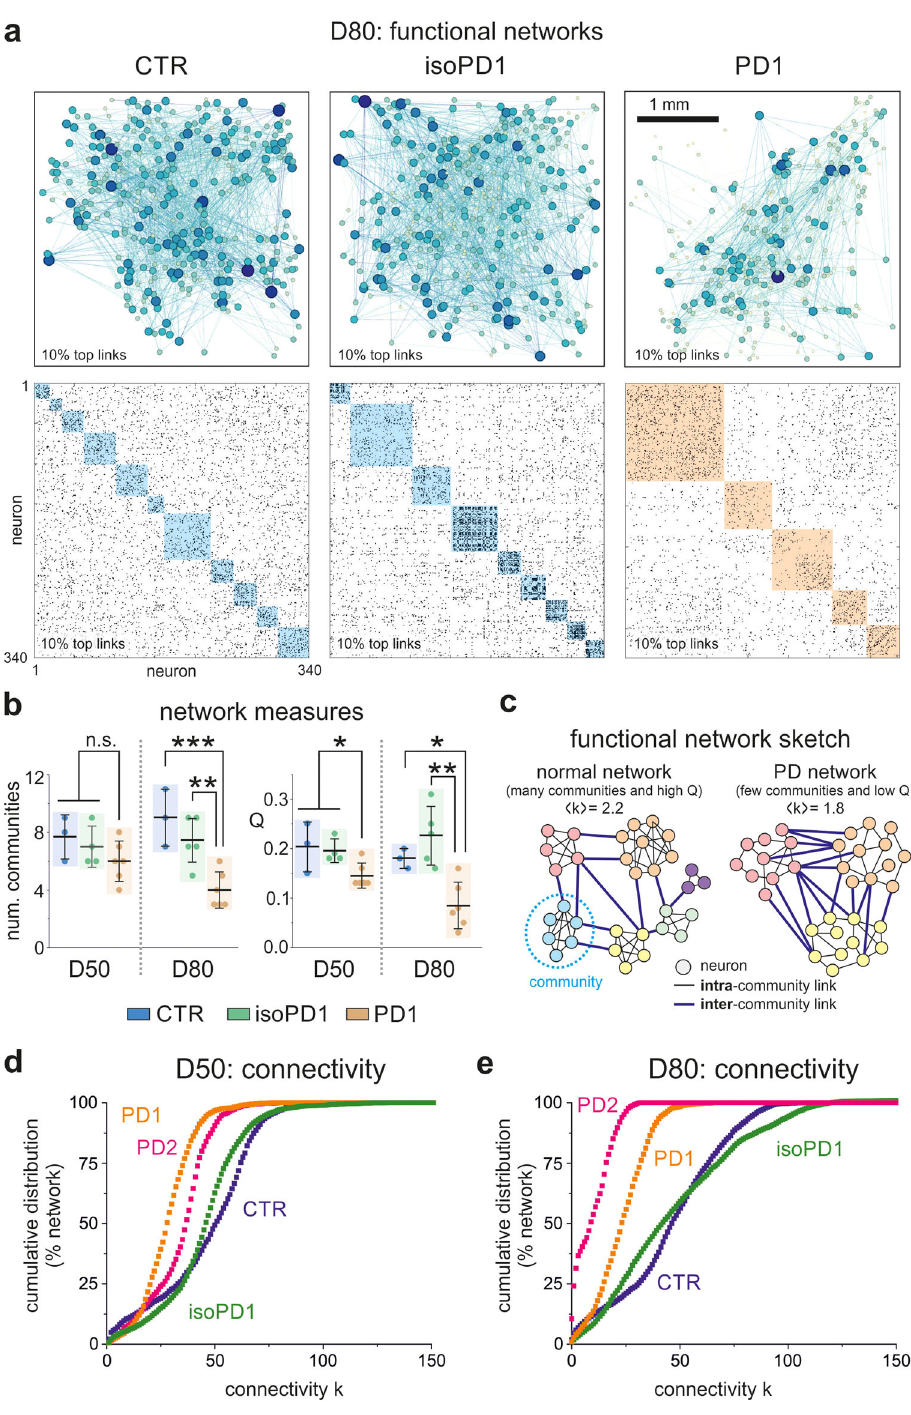
Fig. 3 Functional connectivity of CTR, isoPD, and PD lines. a Top, Representative functional connectivity maps at D80 for CTR, isoPD1, and PD1 cultures. Dots are neurons and lines functional connections. The diameter of a dot and its opacity is proportional to the connectivity of the neuron it represents. Bottom, corresponding functional connectivity matrices. Black points are functional connections and colored boxes are functional communities. b Comparison of the number of communities and community statistic Q for the three lines at D50 and D80. PD1 networks are excessively integrated, with a relatively small number of communities strongly interconnected (low Q) as compared to CTR and isoPD1 networks. The colored boxes are a guide to visualize the distributions, which show the mean±SD and the individual realizations (dots). Number of independent experiments: D50 (CTR: n = 3, isoPD1: 4, PD1: 6); D80 (3, 5, 6). **** p < 0.001; ** p < 0.01; * p < 0.05 (ANOVA with multiple comparison analysis). c Sketch of functional differences between normal and PD networks according to the data, with PD networks displaying on average a lower connectivity combined with fewer and excessively connected communities. d Cumulative distribution functions (CDF) of functional connections (in % of network) at D50 for CTR, PD1, PD2, and gene-edited isogenic PD1 line (isoPD1). The CDFs of the two PD lines exhibit a trend toward a lower connectivity as compared to CTR and isoPD1 ones, which are similar. e Corresponding distributions at D80. The two PD lines maintain their low connectivity pro fi les and strengthen their differences relative to CTR and isoPD1, which remain similar. The number of independent experiments used in panels ( d ) and ( e ) are D50 (CTR: n = 3, isoPD1: 4, PD1: 6, PD2: 5); D80 (3, 5, 6, 5). npj Parkinson’s Disease (2021)